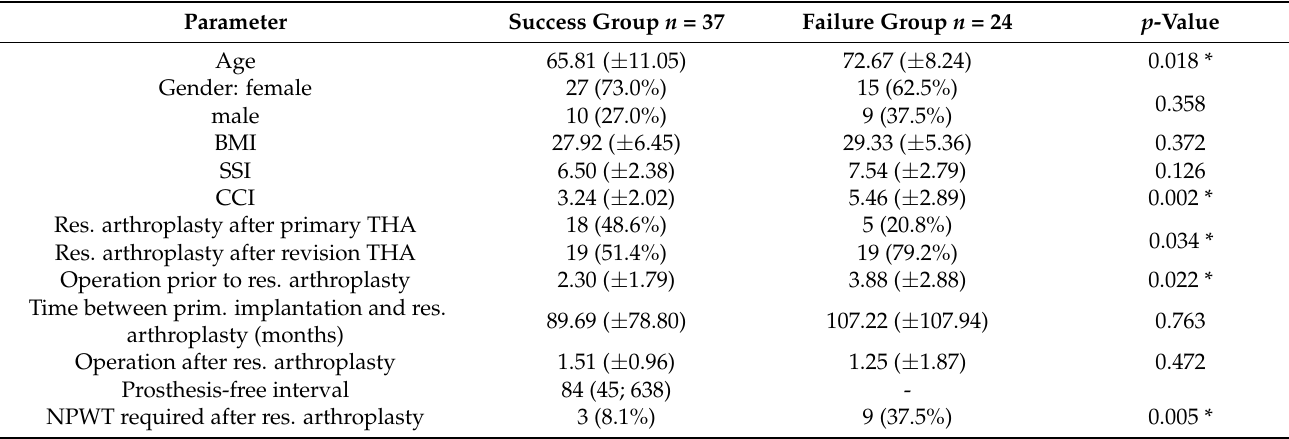
Table 1. Comparison of demographics and risk factors between successful two-stage procedures (success group) and failed two-stage procedures (failure